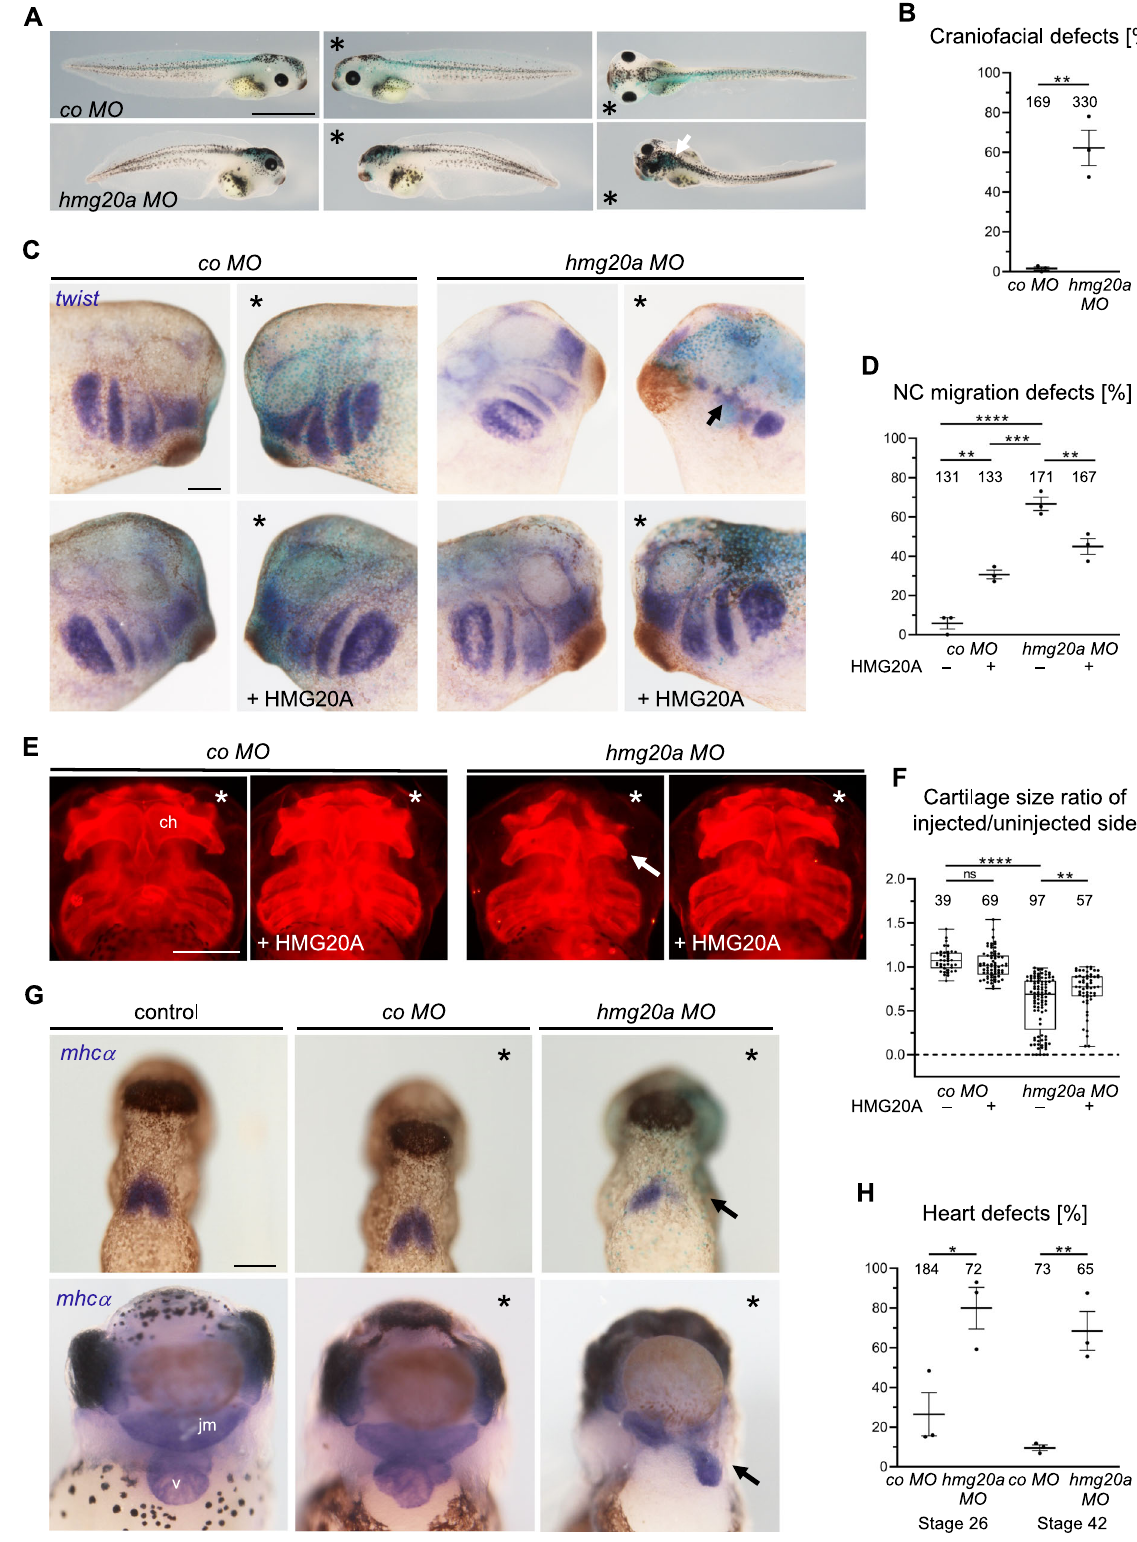
the myo fi broblast/cardiomyocyte marker Acta2 40 (Fig. 6E), thus reinforcing our observation of HMG20A ’ s role in regulating CM transcription